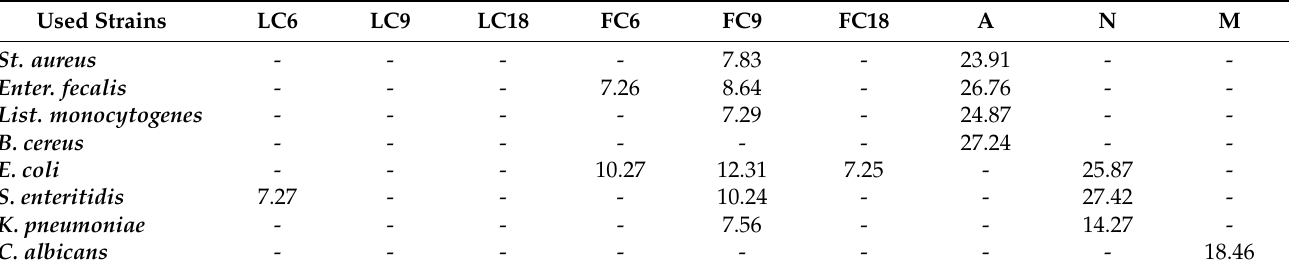
Table 6. The in vitro qualitative screening—the disk diffusion